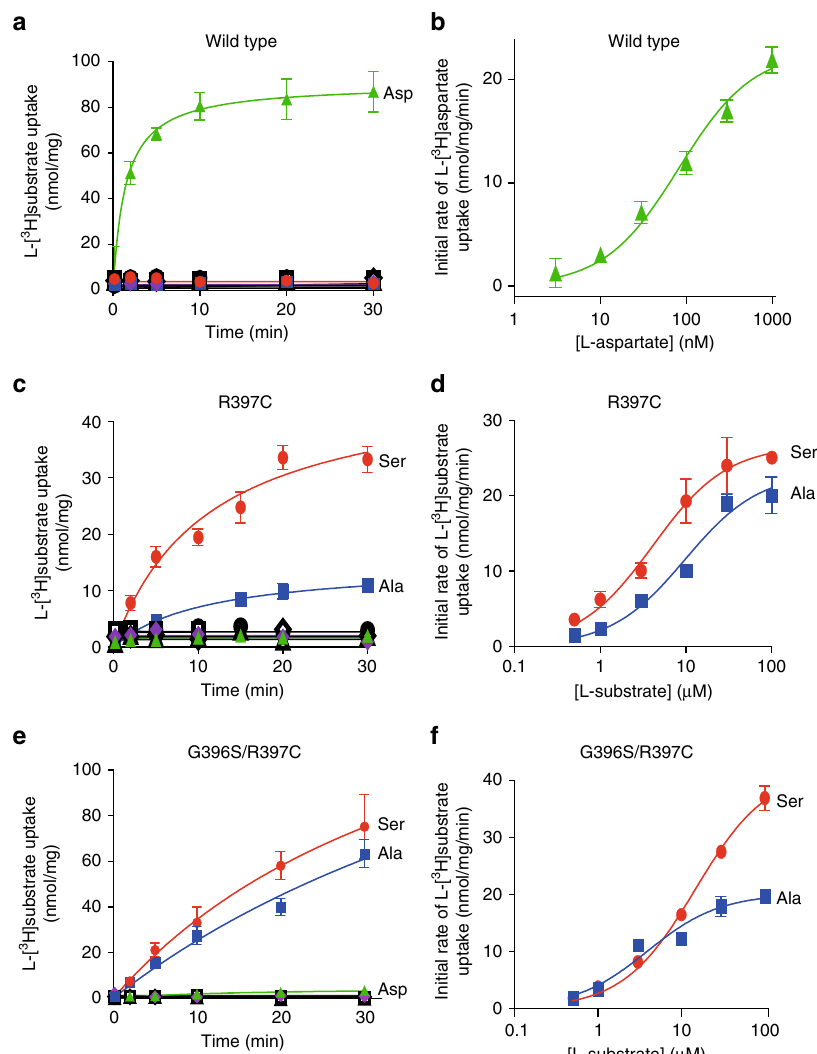
Fig. 3 Mutations in Glt Ph alter the substrate selectivity to prefer neutral amino acids L-[ 3 H]aspartate (100 nM; green triangles), L-[ 3 H]serine (1 µ M; red circles), L-[ 3 H]alanine (1 µ M; blue squares) and L-[ 3 H]glutamine (1 µ M; purple diamonds) transport by wild-type Glt Ph a , Glt Ph -R397C c and Glt Ph -G396S/ R397C e in the presence of an inwardly directed Na + gradient at pH 7.5. Uptake of each substrate in the absence of a Na + gradient is shown in open, black symbols, of which multiple are overlayed. b L-[ 3 H]aspartate concentration – response for wild-type Glt Ph . L-[ 3 H]serine (red circles) and L-[ 3 H]alanine (blue squares) concentration responses are shown for Glt Ph -R397C d and Glt Ph -G396S/R397C f . Values presented are mean ± S.E.M, ( n ≥